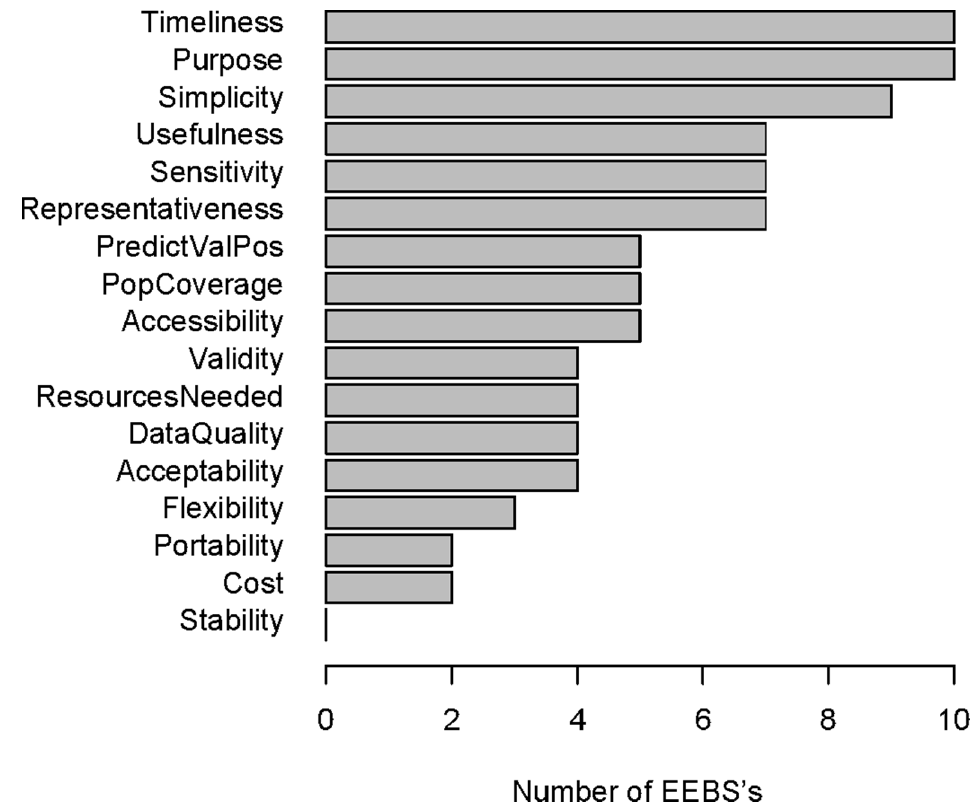
Figure 1. Assessment of variables across EEBS evaluations.